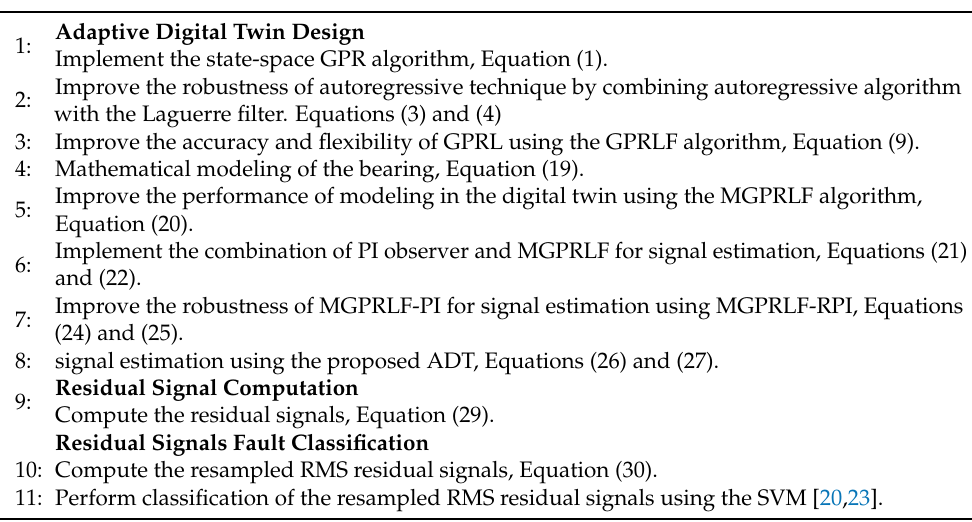
Table 4. The proposed algorithm uses a combination of the adaptive digital twin (ADT) and SVM for fault diagnosis of the